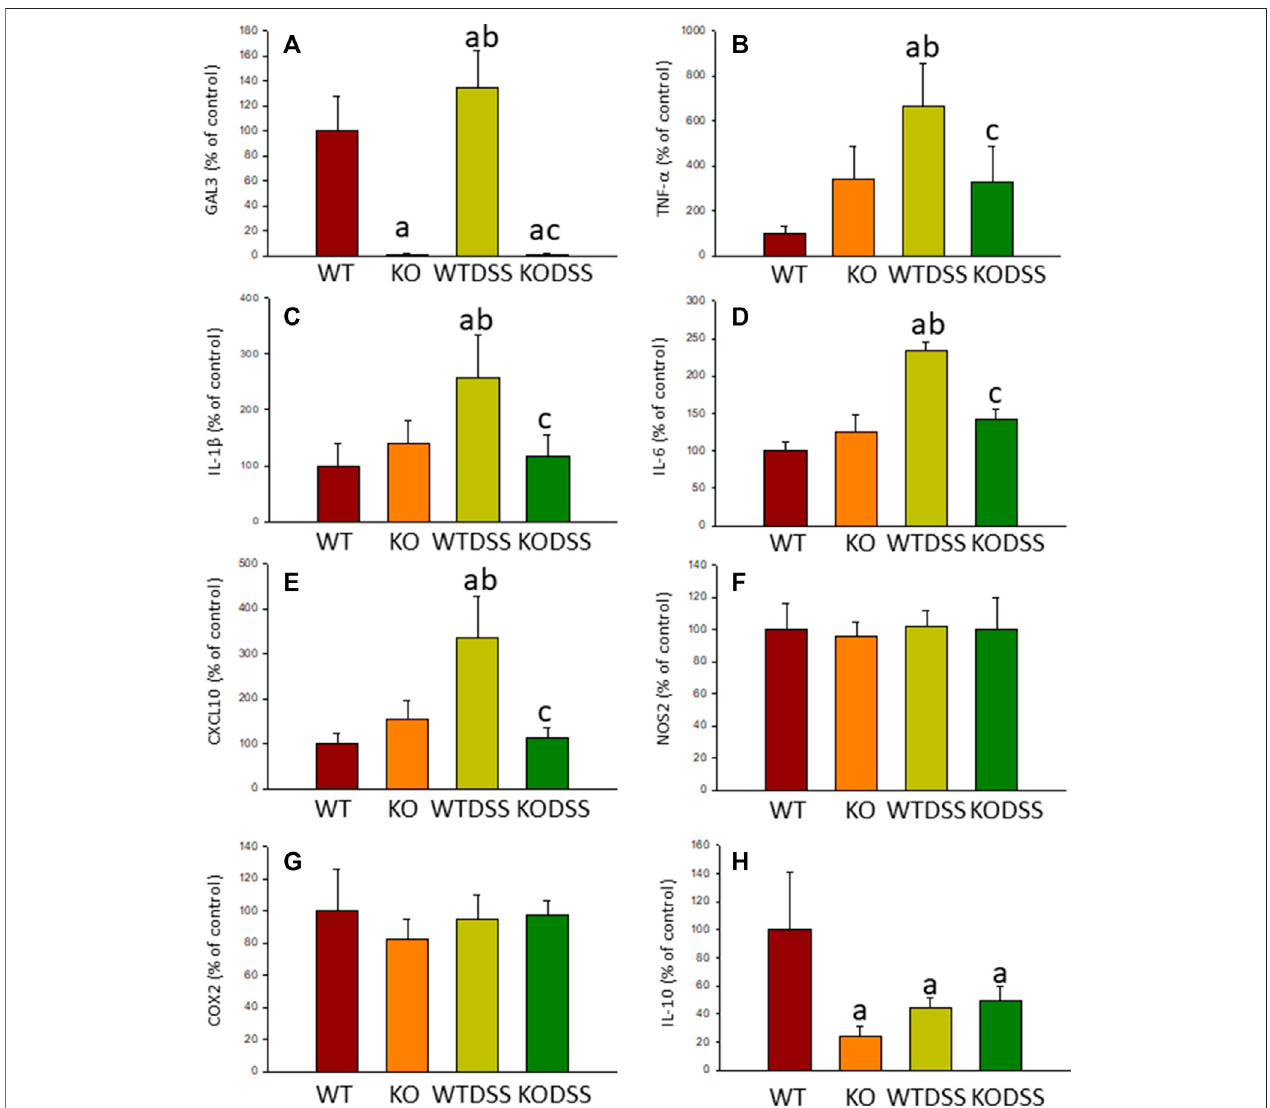
FIGURE 10 | Effect of the DSS treatment on the expression levels of Gal3, TNF- α , IL-1 β , IL-6, CXCL10, NOS2, COX2 and IL-10. Measurement of the effect of the treatment with DSS on the expression levels ofmRNA ofGal3 (A) , pro-in fl ammatory mediators such as TNF- α (B) , IL-1 β (C) , IL-6 (D) , CXCL10 (E) , NOS2 (F) , COX2 (G) and the anti-in fl ammatory mediator IL-10 (H) in the SN of mice from the different experimental groups by using RT-qPCR. Results are mean ± SD of at least three mice per experimental group, normalized to β -actin and expressed as percentage relative to the WT group. Statistical signi fi cance: One-way ANOVA followed by the Fisher ’ sLSD posthoc testformultiplecomparisonswasused,with α (cid:2) 0.05: (a) ,comparedwiththeWTgroup; (b) ,comparedwiththeKOgroup; (c) ,comparedwiththe WTDSS group; p < 0.05. Abbreviations: WT, wild type mice; WTDSS, wild type mice treated with DSS; KO, Gal3 knockout mice; KODSS, Gal3 knockout mice treated with